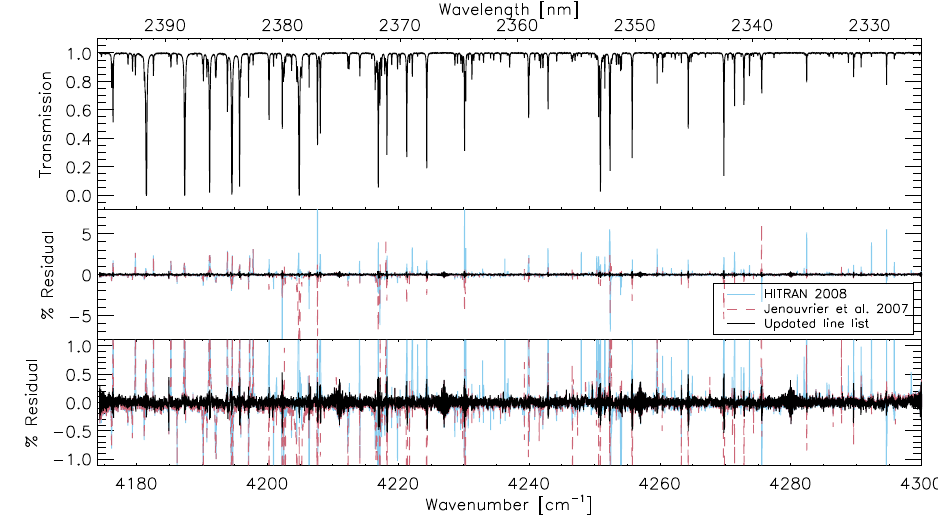
= 4 . 04hPa and P = 333 . 6hPa, adopted from Jenouvrier et al. air 2 O